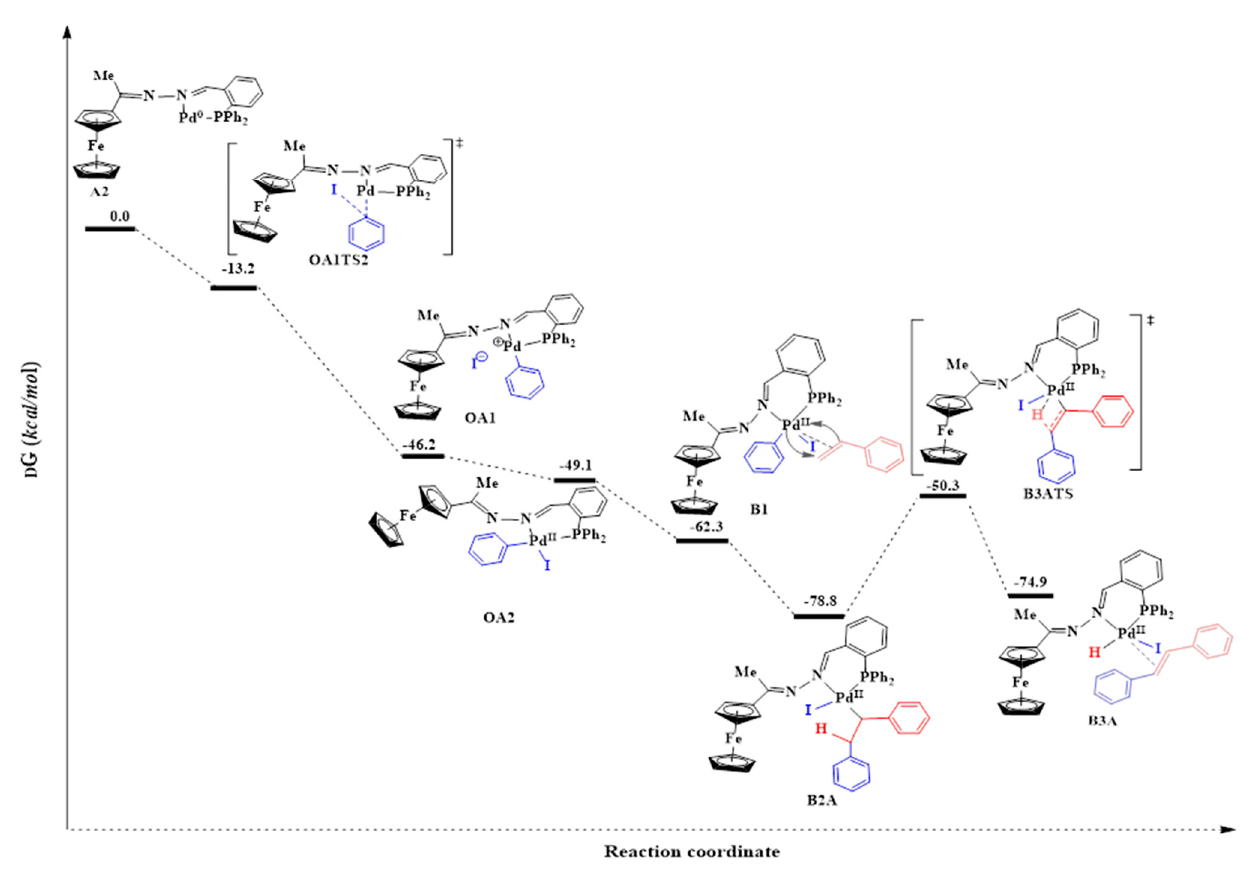
Figure 18. Reaction energy profile for the catalytic steps of the Mizoroki-Heck cross-coupling reaction of iodobenzene with styrene using C3 .